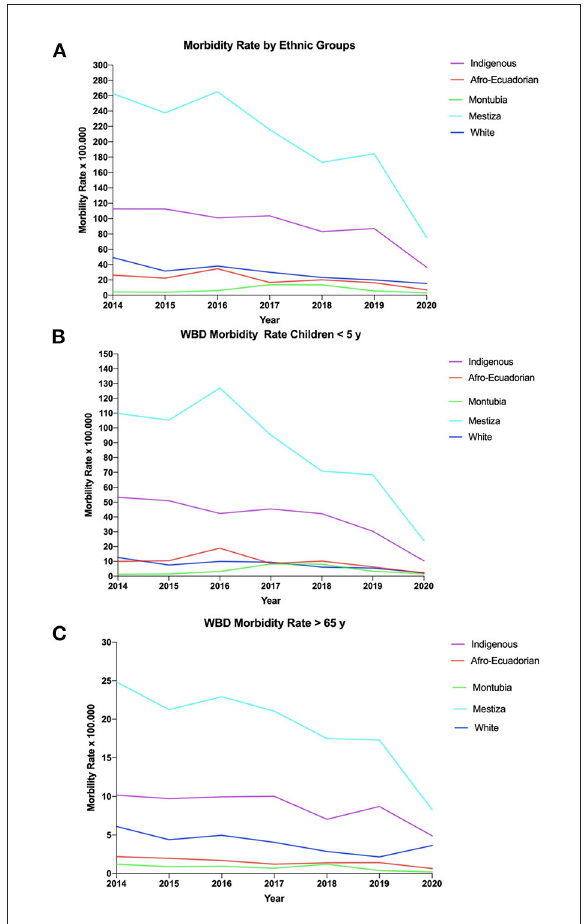
FIGURE1 Morbidity due to waterborne diseases in Ecuador from 2011-2020. (A) Overall Morbility rate in Ecuador. (B) Morbility Rate by ethnic group in children from 0 to 5 years. (C) Morbility rate by ethnic group in patients over 65 years of